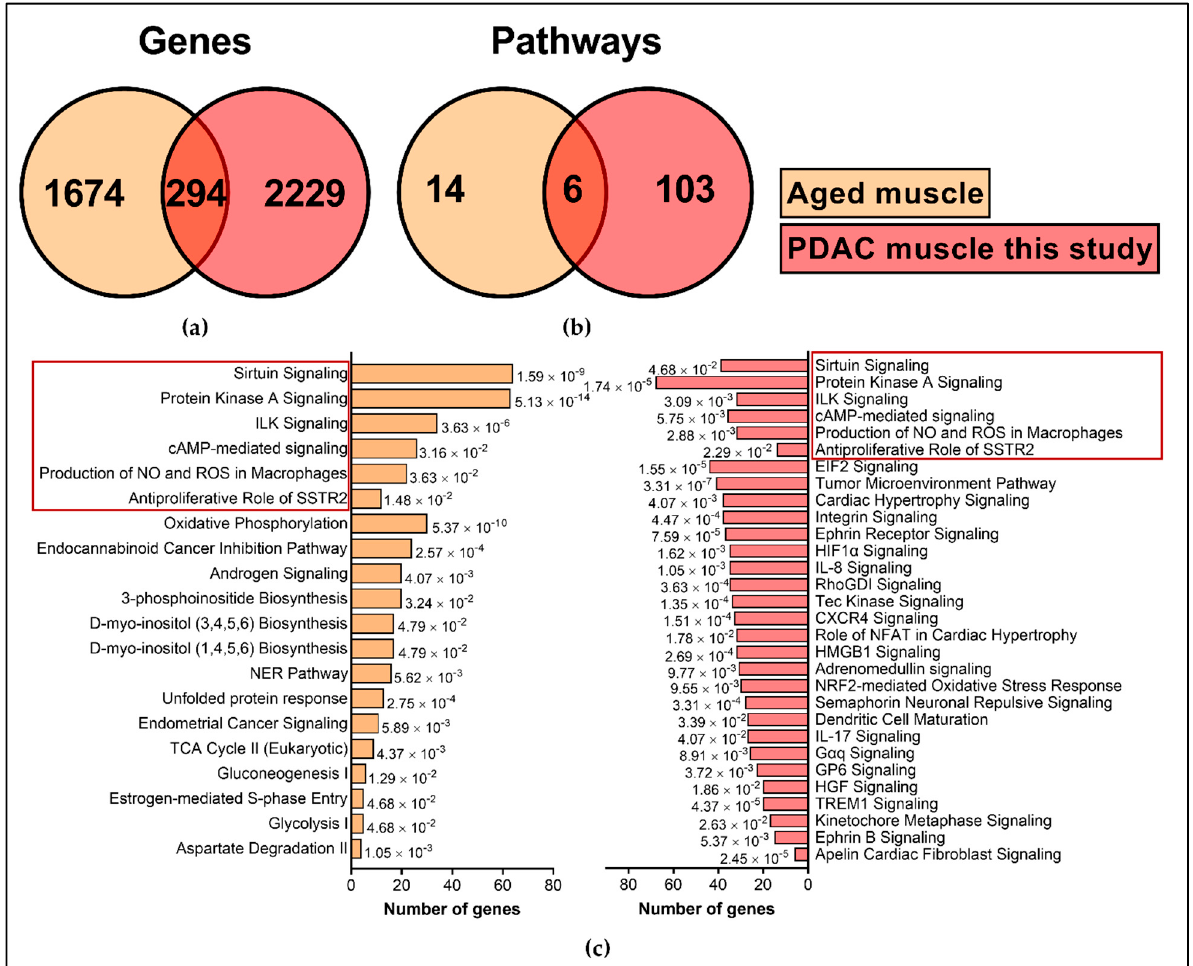
Figure 10. Comparison of age-related transcriptome against PDAC muscle. ( a ) For muscle, 294 genes were common between PDAC muscle (this study) and GSE9676. ( b ) There was a minimal overlap between pathways. ( c ) The list of significant pathways with z-score of 1.5 and p < 0.05 are represented for GSE9676 and top 30 pathways in PDAC muscle. The common pathways between the two datasets are highlights in red.